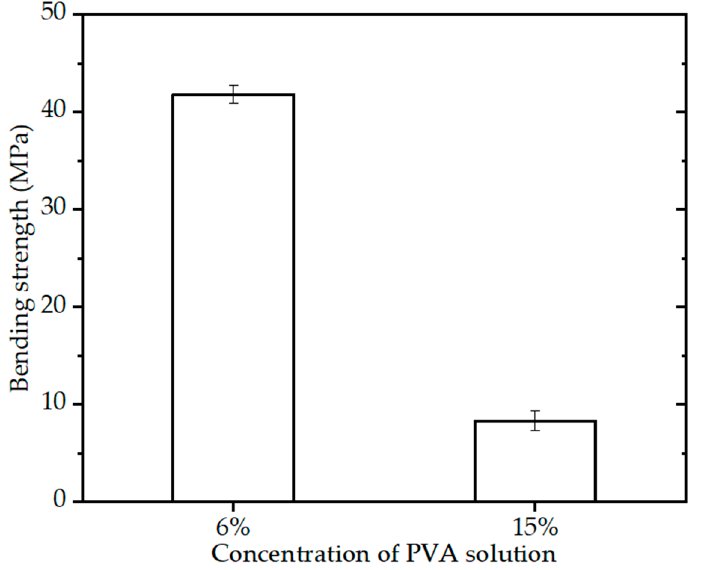
Figure 6. Bending strength of the BINs with different paste component after one-step sintering at 1200 °C for 3 h ( p < 0.05).